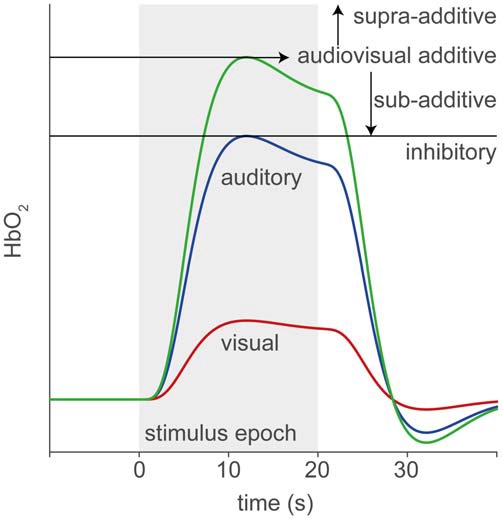
Rationale of audiovisual (AV) fNIRS experiments. Hemodynamic responses taken from temporal cortex will differ for the different stimulus modalities, such that to an auditory (blue line) stimulus (gray patch) the response amplitude is larger than to a visual (red) stimulus. We test for potential multisensory integration at the level of temporal cortex, by comparing the hemodynamic response to bimodal stimulus presentation (green) to the linear sum of the visual and auditory responses (additive). Supra- or sub-additive effects on the AV response may be a signature for AV integration.